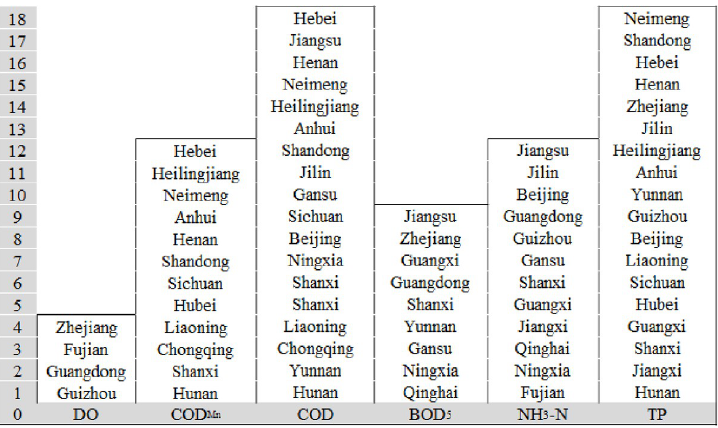
Fig 8. Provinces where six elements exceeded standard limits (the ordinate represents the ranking of F 2 values in different